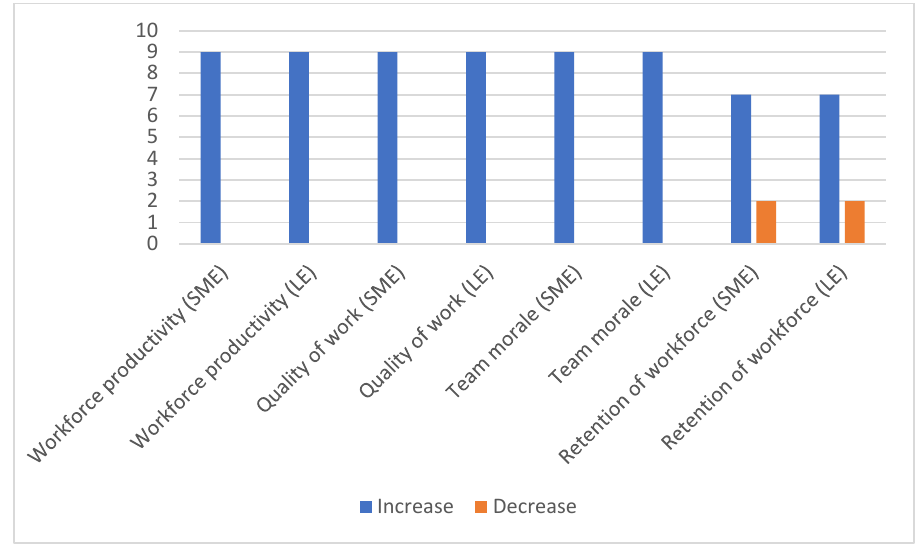
Figure 3. Participants’ responses on the impact of IoT on productivity, quality of work, team spirit, and retention of workforce for SMEs and LEs.